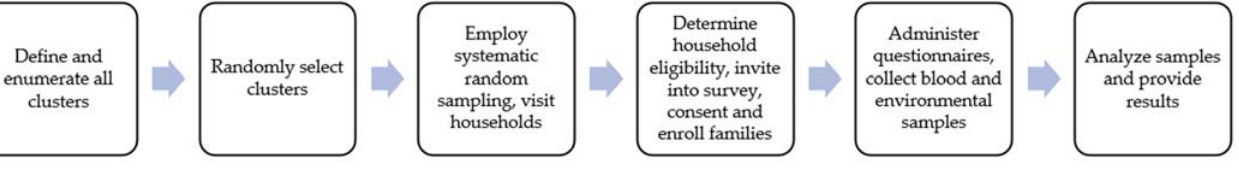
Figure 1. Cluster sampling flow chart: stage one and stage two.